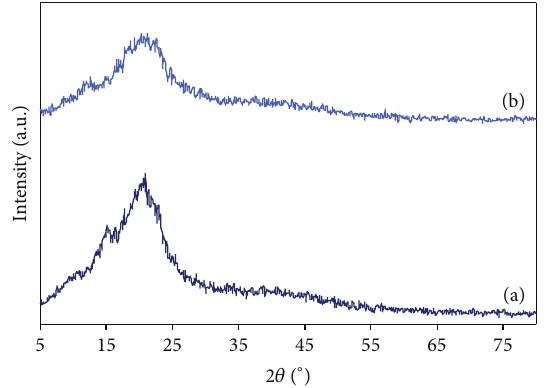
Figure 1: X-ray diffractogram of (a) pure chitosan (CS) and (b) chitosan : LiCF 3 SO 3 (90 :10) system.